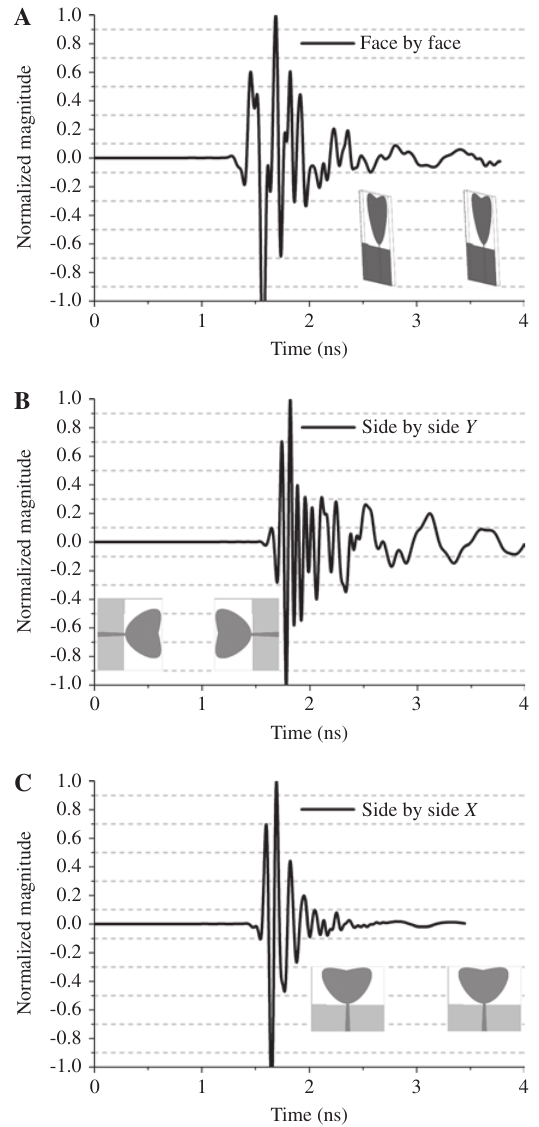
Figure 10: The input pulse with τ = 67 ps.